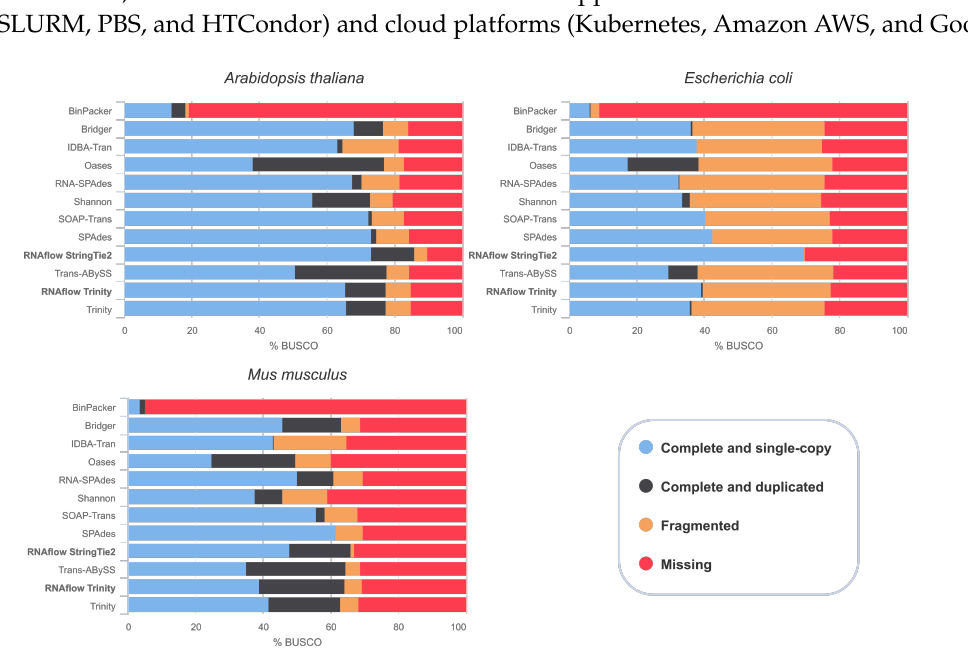
Figure 6. BUSCO assessment. Results of benchmarked universal single-copy orthologs for E. coli , A. thaliana and M. musculus RNA-Seq data sets that were obtained from Hölzer and Marz [38]. RNAflow ’s assembly results are indicated in bold. The previously calculated assemblies were obtained from Hölzer and Marz